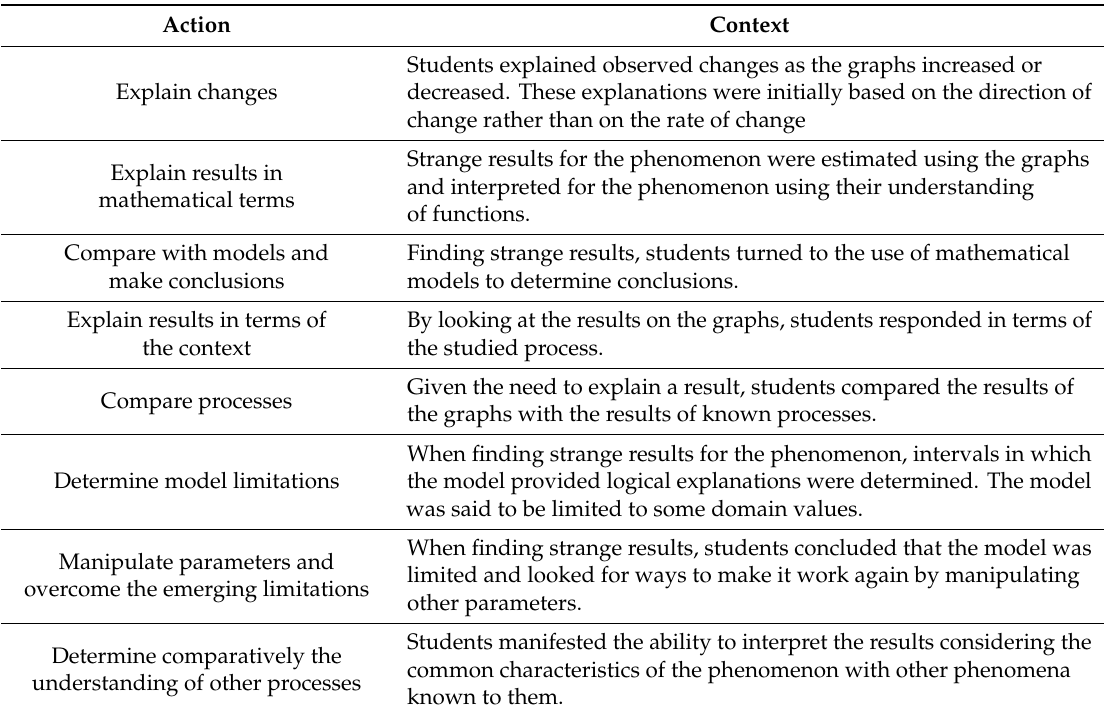
Table 4. Student considerations on the e ff ect of A and V values over the ratio A /